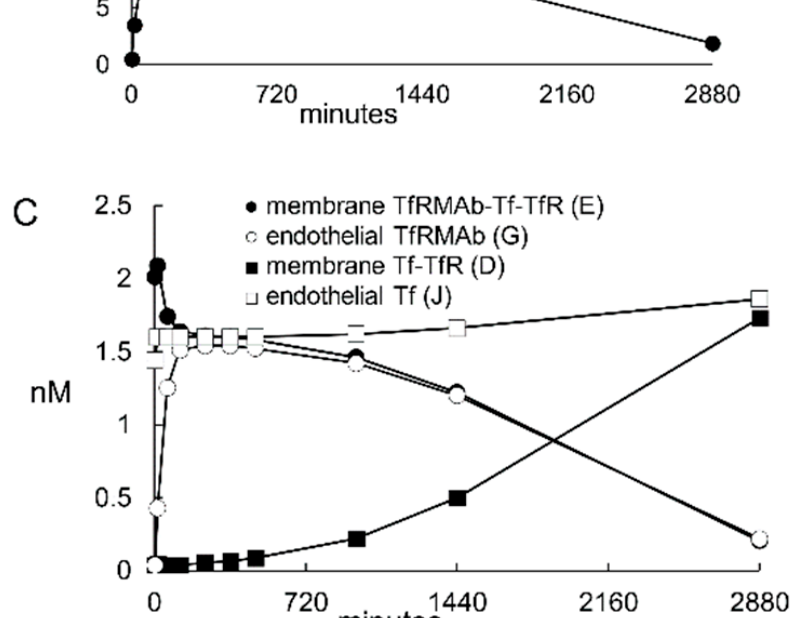
= 3.6 nM) TfRMAb. The plot shows the D